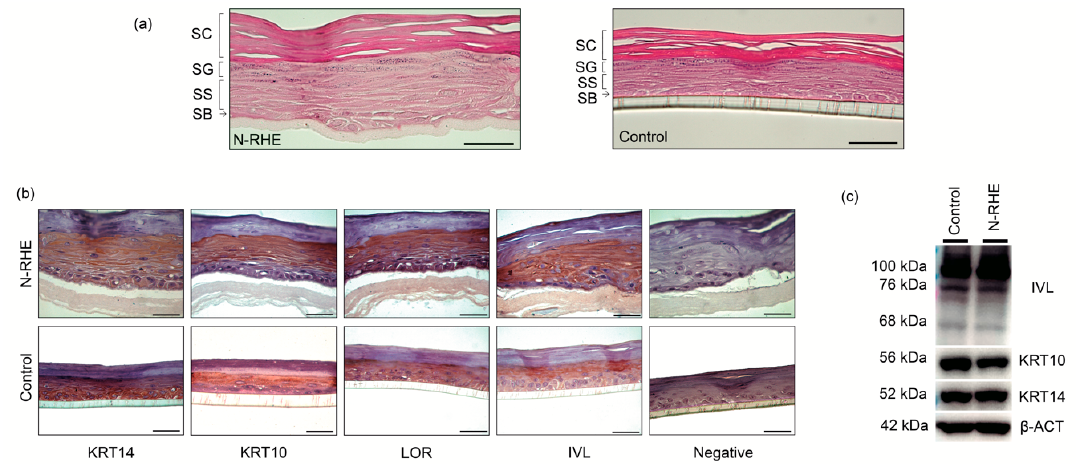
Figure 4. Morphology and immunohistochemistry of reconstructed human epidermis. Reconstructed human epidermis (RHEs) where N-RHE is the model with an N6 / 6 sca ff old and the control model is the USP-RHE model. ( a ) Comparison between the control (USP-RHE) model and N-RHE model by H&E staining: Stratum corneum (SC), stratum granulosum (SG), stratum spinosum (SS), stratum basale (SB); ( b ) immunostaining of N-RHE and control models with KRT10, KRT14, LOR, IVL expression and negative (free of primary antibody); ( c ) Western blotting analysis for KRT10, KRT14, IVL, β -ACT. Magnification = 50 × . Bar = 50 µ